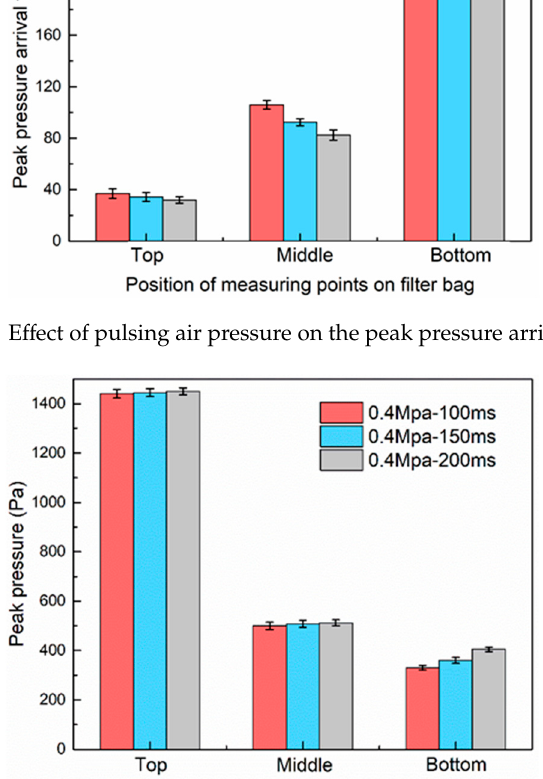
Figure 8. Effect of the pulsing air injection time on the peak pressure arrival time of filter bag. 3.2. Effect of Venturi Length and Throat Diameter on the Cleaning Performance of the Filter Bag Figure 9a illustrates the variation of the peak pressure on the filter bag under different venturi throat diameters (40, 50, and 60 mm) at a pulsing air pressure of 0.4 Mpa, pulsing air injection time of 100 ms, and venturi length of 200 mm. The peak pressure in the point P0 was negative, later increasing until reaching a maximum value at the point P1. Subsequently, the peak pressure decreased with an increasing distance from the measuring point to the bag mouth. Finally, the peak pressure rose again at point P8. As shown in Figure 9b, when the typical venturi-type tube was installed in the bag cage, the area near the bag mouth was in the “blind action zone” of the cleaning airflow (primary airflow and secondary airflow). In addition, when the cleaning airflow was ejected from the venturi tube, the airflow outside the filter bag near P0 would be induced to the inside, creating a negative pressure zone in the area near the bag mouth. It can be seen that the area near P0 is the one with the worst cleaning performance. This inference is consistent with the literature [3,20]. Since, in this point, the dust layer cannot be effectively cleaned, the filter material in this area loses its filtration ability. Thus, it should be considered that installing the typical venturi-type tube implies that the area near the filter bag mouth will exhibit low filtration performance. The maximum value of the peak pressure occurred at P1, which was consistent with the results of literature [21,22]. In the process of moving downward from the bag mouth, the cleaning airflow expanded and diffused outside the filter bag. Since the cleaning airflow could not be infinitely expanded, and the consumption and energy loss of the cleaning airflow accompanied the whole process, it was inevitable that there would be a maximum pressure on the side wall of the filter bag. After the maximum pressure occurred, the expansion effect of the cleaning airflow decreased and the energy